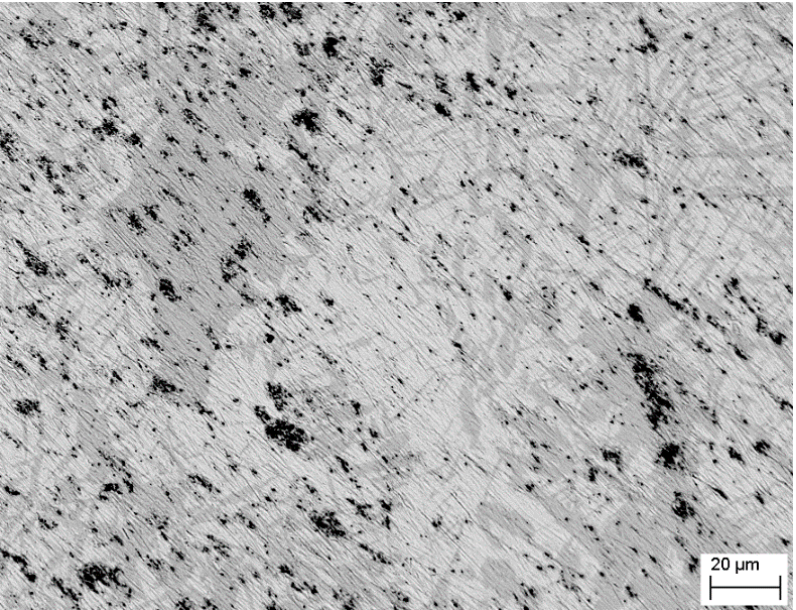
Figure 1. A scanning electron microscope (SEM) secondary electron image of the material synthesized; light gray—Ag 1 . 2 Cu 0 . 8 S, dark gray—AgCuS, and black—pores.